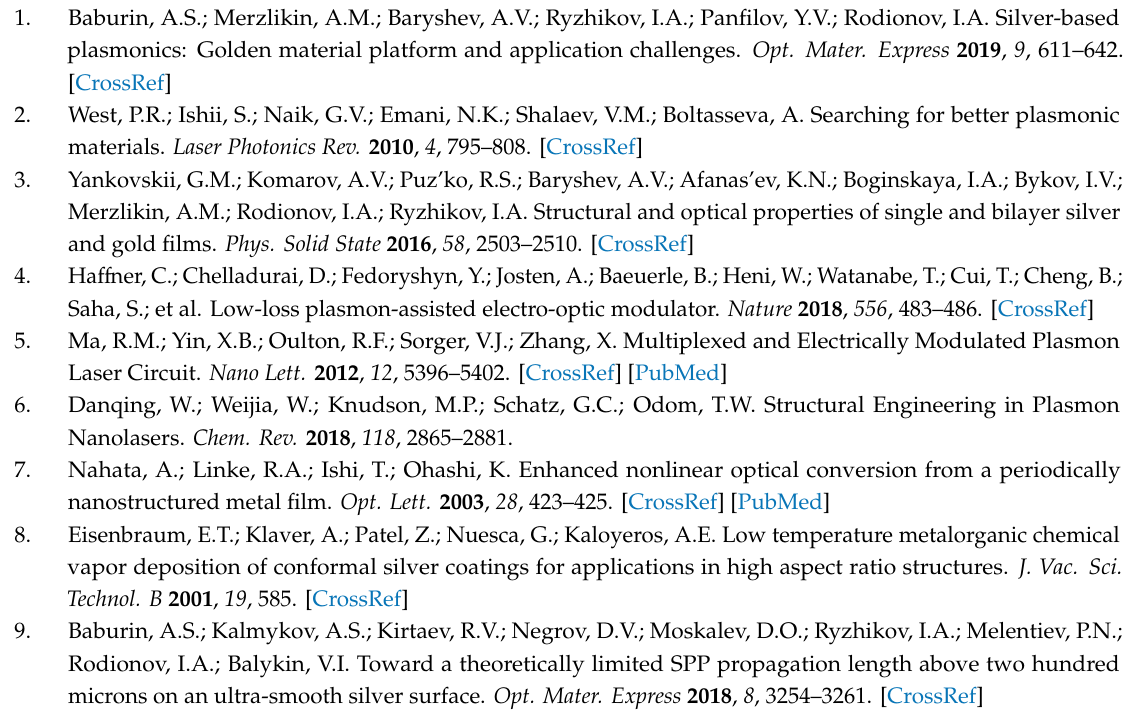
Figure S1: SEM images of Ag thin films, Figure S2: AES of Ag thin